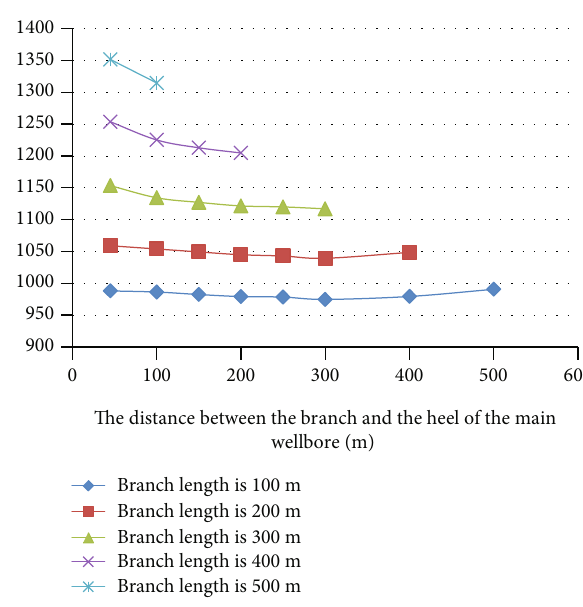
Figure 12: Production rates with di ff erent positions of the second branch.